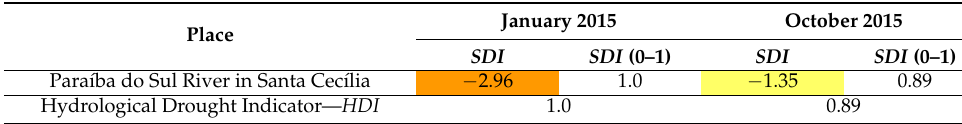
Table 10. Hydrological drought indicator (HDI ) application.